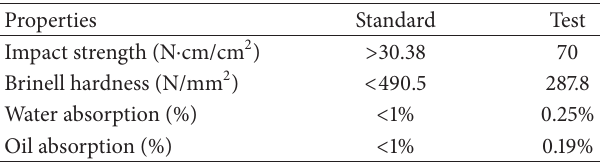
Table 2: Main mechanical properties of the WSM-3 nonasbestos brake shoe.